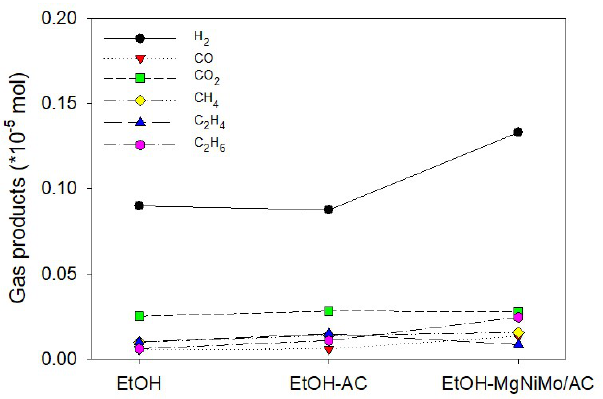
Figure 3. Gas production after supercritical reaction (reaction conditions: biocrude oil = 20 g, ethanol = 80 g, AC or MgNiMo/AC = 4 g, temperature = 340 ◦ C, reaction time = 2 h, N 2 initial pressure = 30